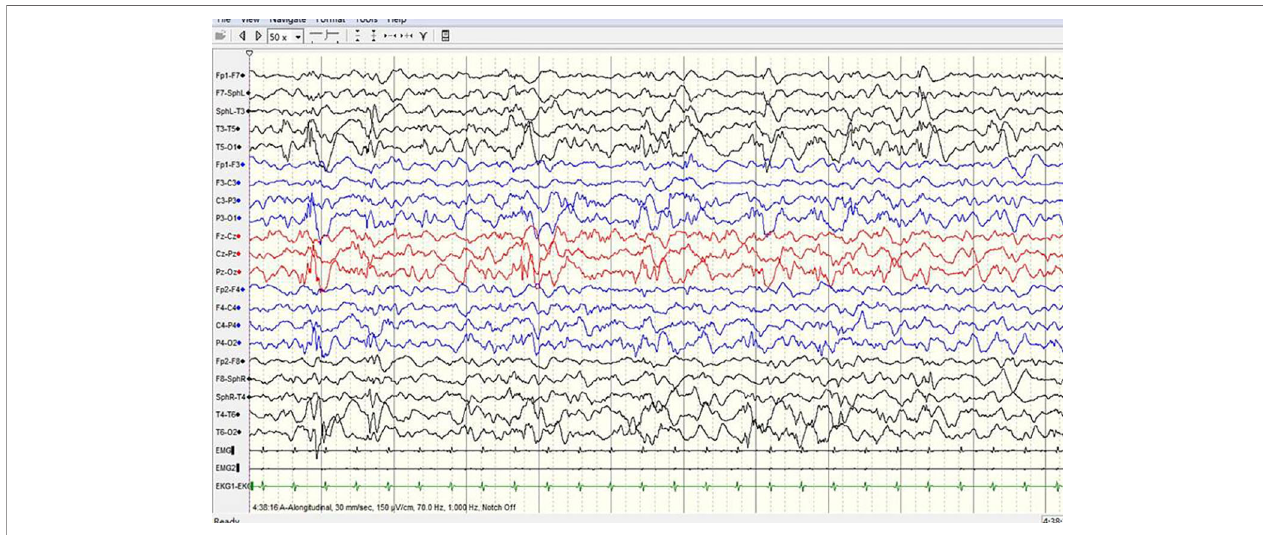
FIGURE 3 | A sample EEG recording of 8-month-old child in this study. The interictal EEG recording shows prime spike waves, a small number of multiple spike waves, spike-slow waves, and multiple spike-slow wave synchronous or non-synchronous discharge (atypical hypsarrhythmia) onto the bilateral rear